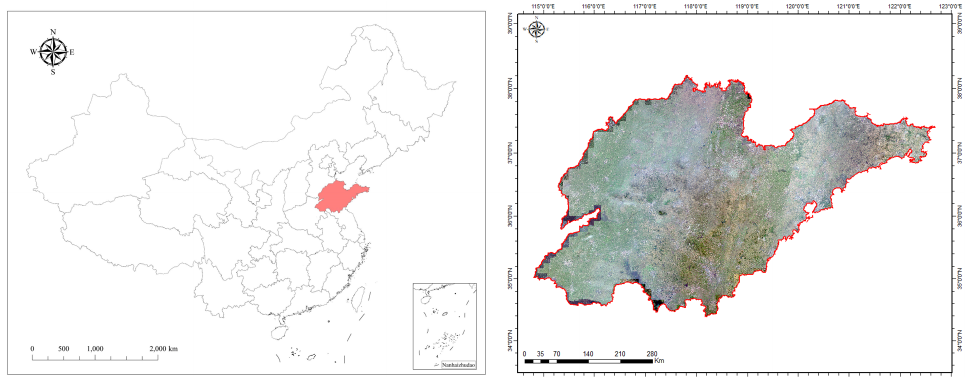
Figure 1. The location of the study area. The map on the left indicates the specific location of the study area in China, and the map on the right shows the Gaof en-1 satellite image of the study